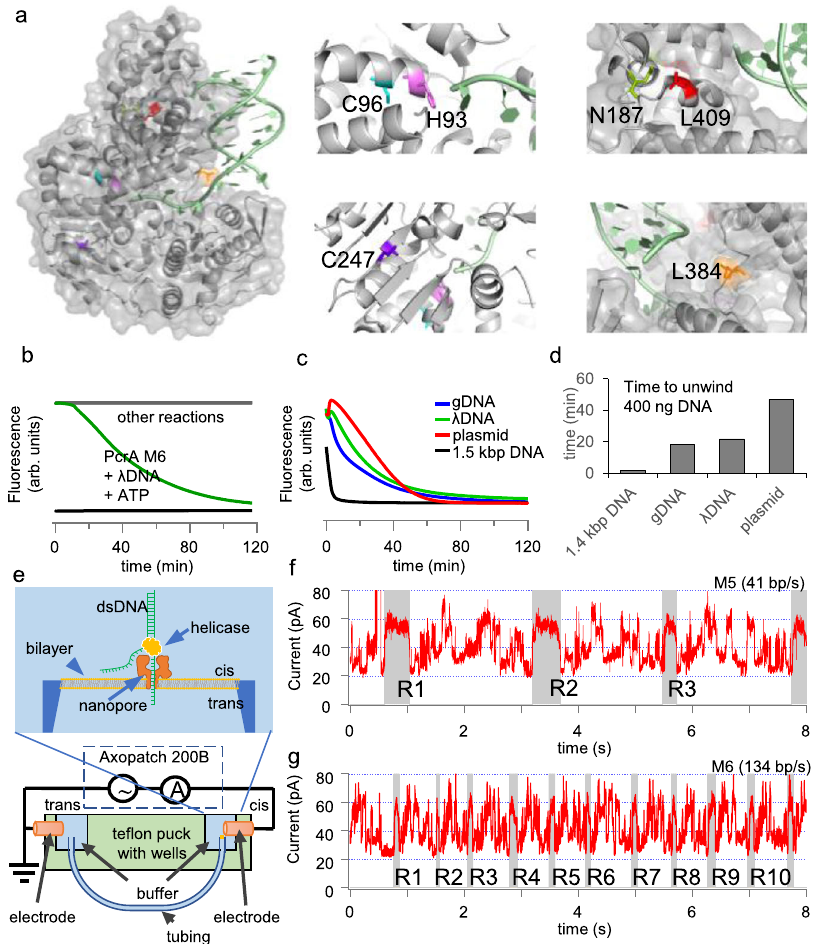
Fig. 7 | Structure and characterization of PcrA M6 unwinding kinetics. a Structure of wild-type PcrAand location of point mutations H93A, C96A, N187C, C247A,L384V,L409Cforimproved activity. ThePcrAstructurewasobtained from the UniPortdatabase, accession number “ P56255 ” . b Unwinding of λ DNA occurred in the presence of PcrA M6, SSB and ATP. Other reactions λ DNA+SSB, PcrA M6+ λ DNA,PcrAM6+ATP+ λ DNAshowednounwinding. c Unwindingofdifferent DNAsubstratesconcentratedat20ng/ μ LinthepresenceofPcrAM6,SSB,andATP. d TimeneededtounwinddifferentDNAsubstratesinthepresenceofPcrAM6,SSB